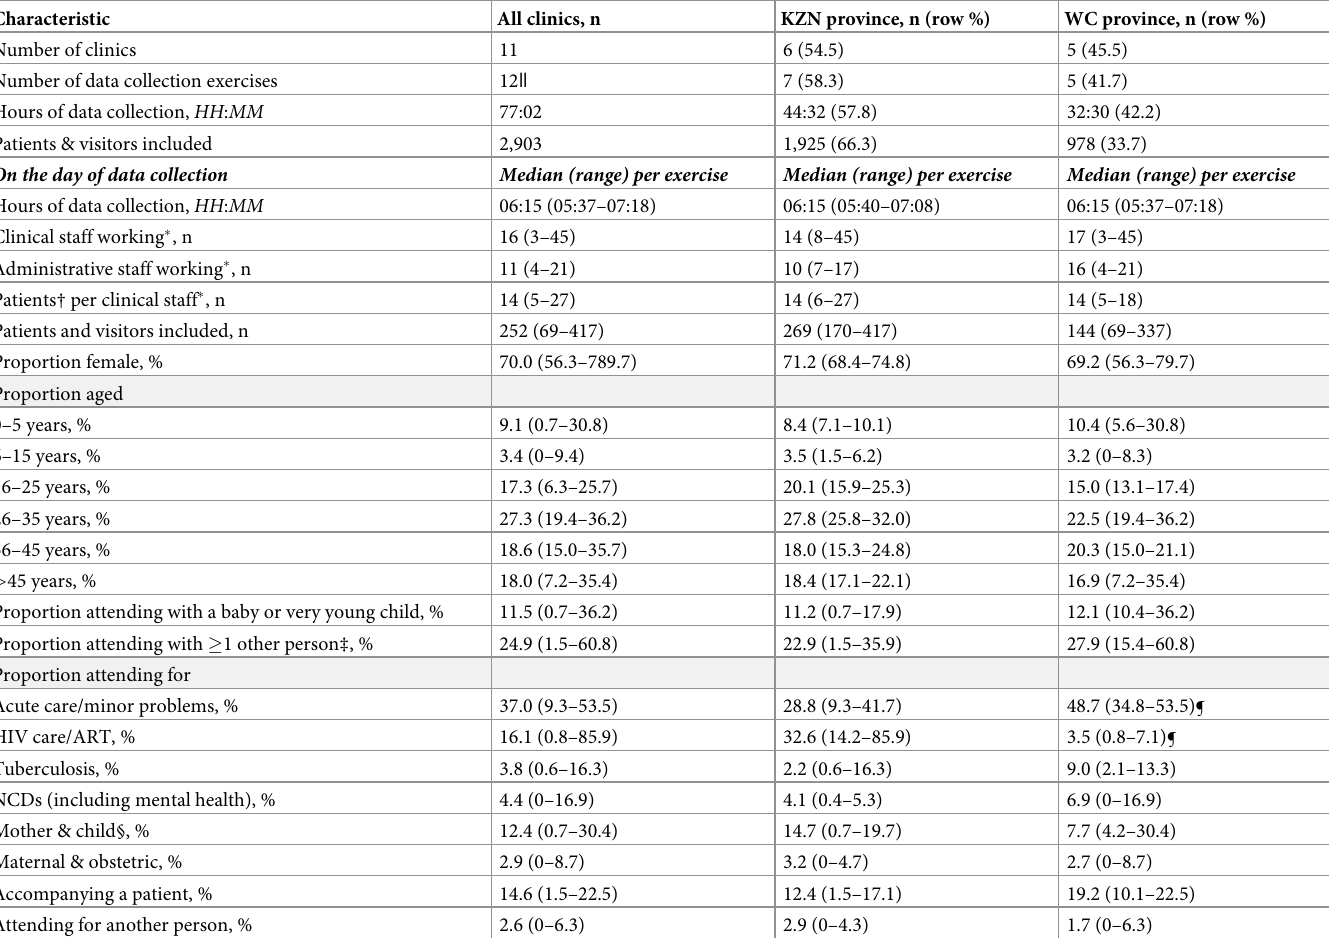
Table 1. Characteristics of clinics, individuals attending, and staff working on the day of data collection, overall and by province (N = 12 exercises at 11 clinics; N = 2,903 attendees).